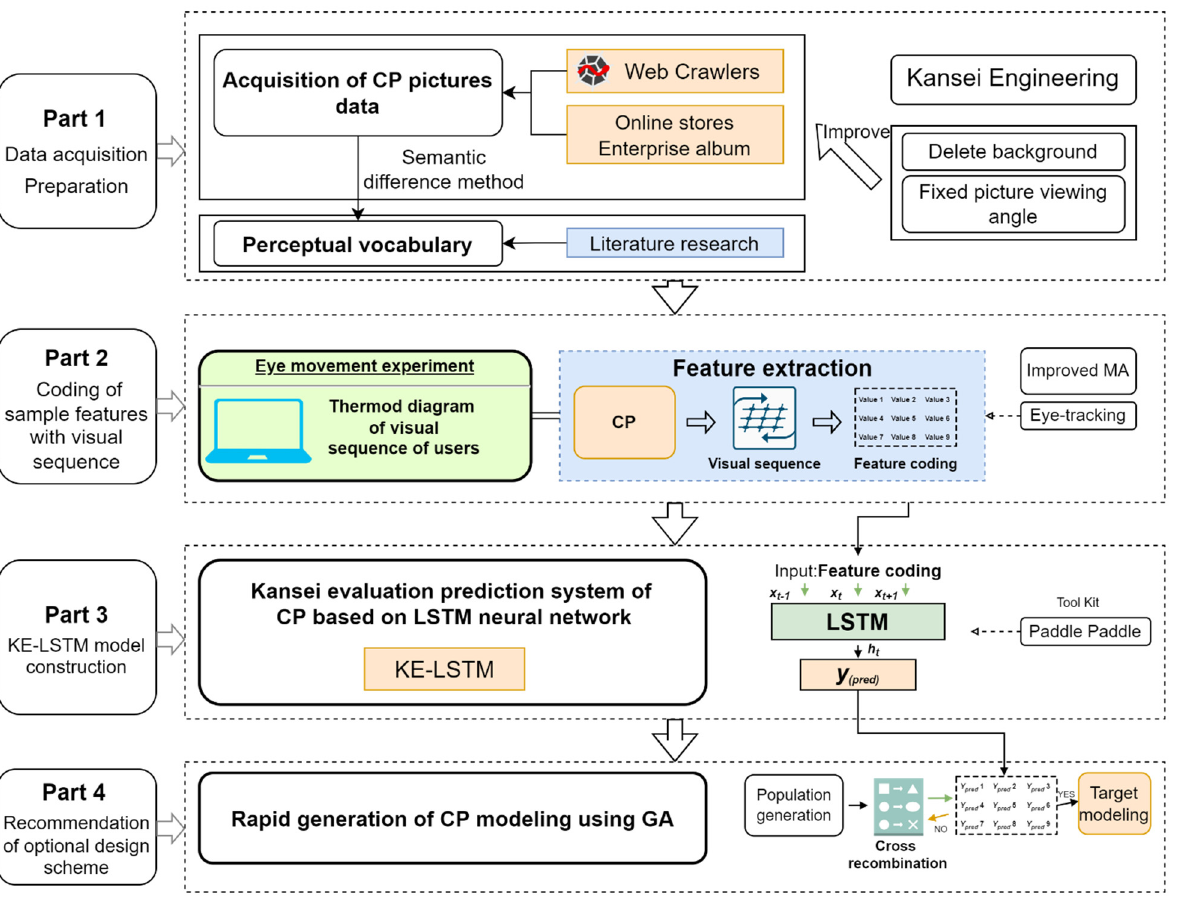
Figure 1. Framework diagram of the CP-KEDL method.